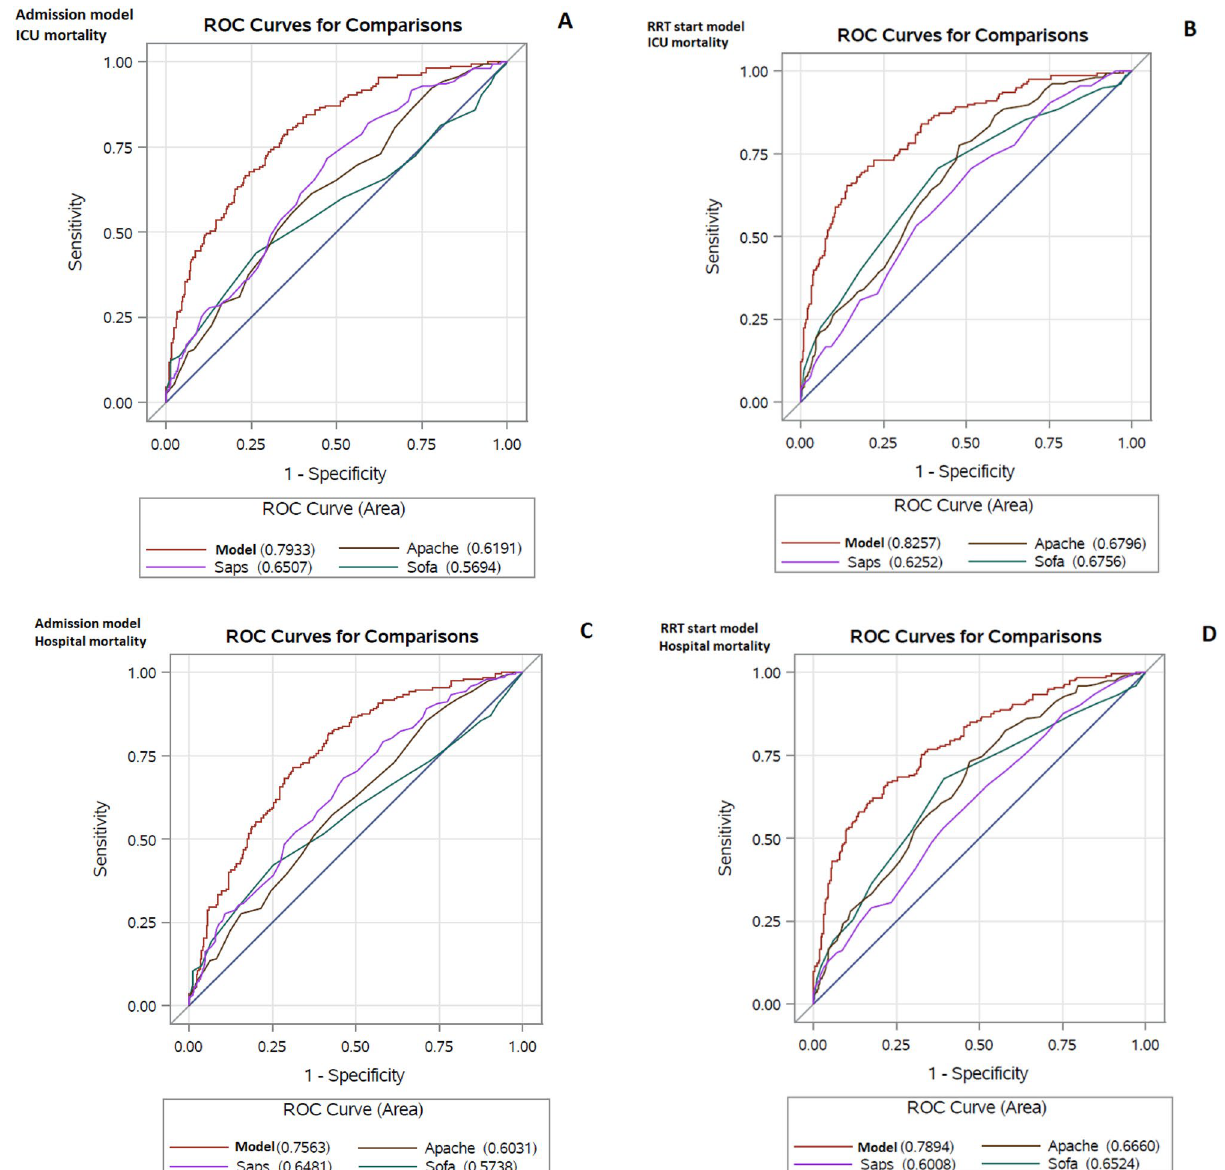
Figure 1. Receiver operating characteristics (ROC) curves for the final multivariable models for ICU and hospital mortality in the CRRT model development cohort. ( A ) ICU admission model for ICU mortality; ( B ) the MALEDICT RRT initiation model for ICU mortality; ( C ) ICU admission model for hospital mortality and ( D ) the MALEDICT RRT initiation model for hospital